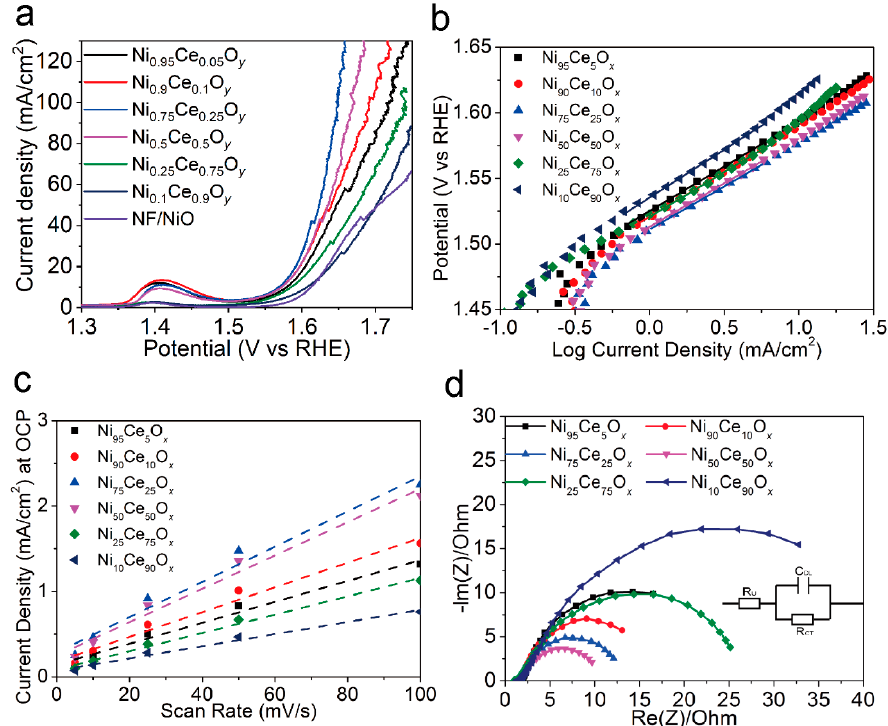
Figure 4. ( a ) Polarization curves of the NF/NiO substrate and Ni y Ce 100- y O x catalysts for the OER with a scan rate of 10 mV/s. ( b ) Tafel plots obtained from the steady–state polarization curves with a scan rate of 1 mV/s. ( c ) Current density at OCP vs. CV scan rate for Ni y Ce 100- y O x samples. The slope of current density at OCP vs. scan rate stands for the double–layer capacitance. ( d ) Nyquist plots of Ni y Ce 100- y O x samples obtained at 1.55 V vs. RHE. The inset is the electrical equivalent circuit. Table 1. Electrochemically active surface area (ECSA), Tafel slope, mass-transfer resistance ( R CT ) and the overpotential ( η ) for the current density of 10 mA/cm 2 for each catalyst investigated in 1 M KOH. Catalyst ECSA/cm